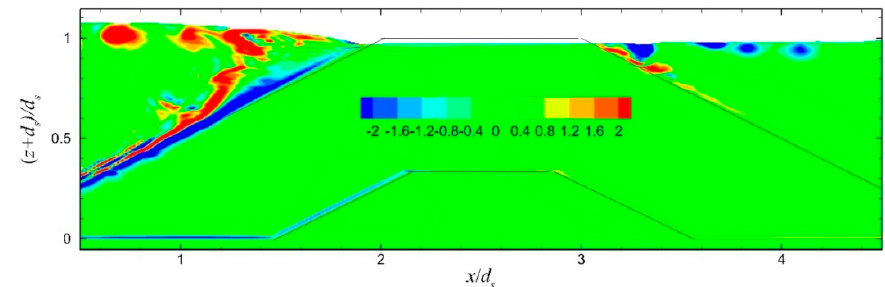
Figure 9. Vorticity field near the crest and in the ZFB trunk (case 5) at one instant (T / 8) during the 30th wave period.